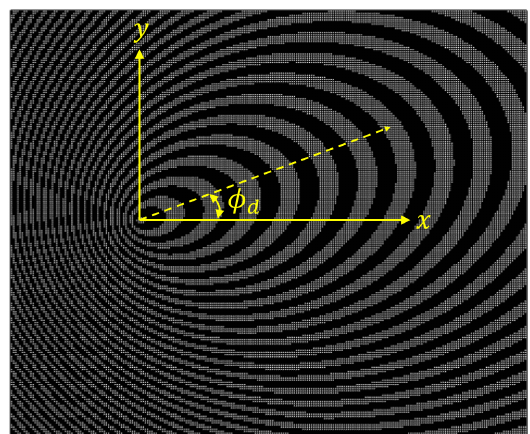
Figure 10. The holographic pattern of the surface-reactance profile needed to form a pencil beam along ( θ d , φ d ) .